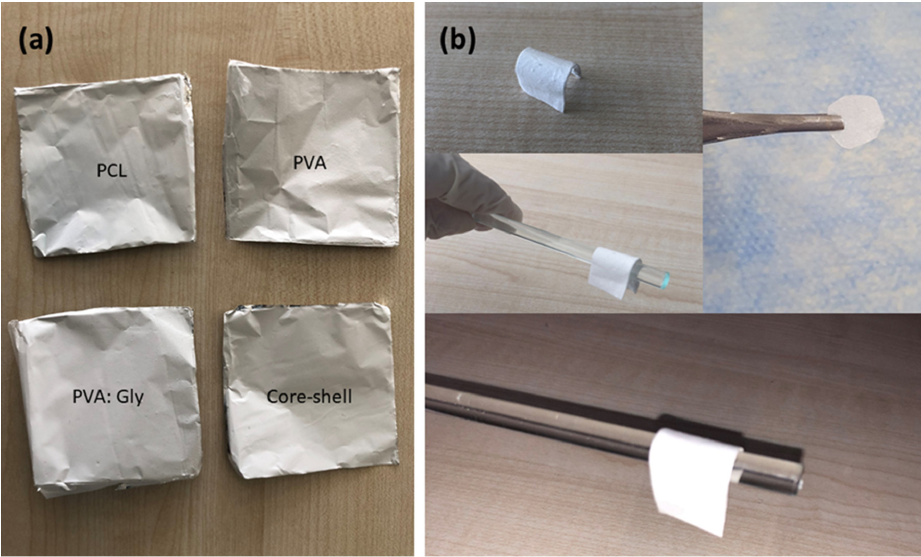
Figure 2. ( a ) Macroscopic images of the prepared membranes; ( b ) Core-shell membrane bending, space making and different macroscopic views.